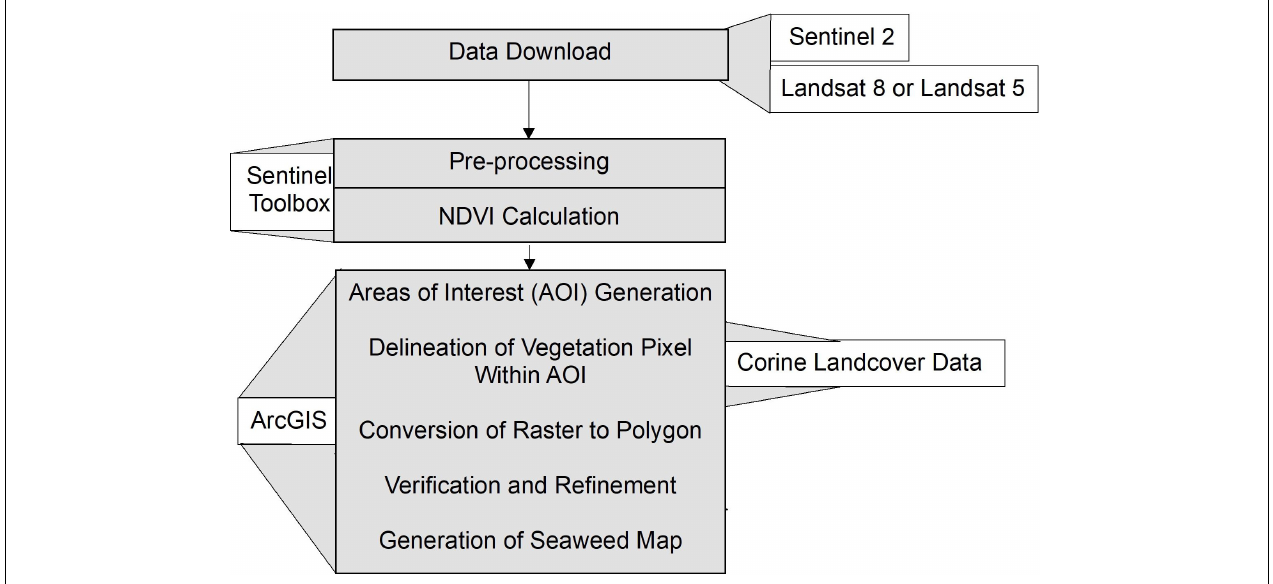
FIGURE 2 | The workflow developed for mapping blooms using the NDVI delineation